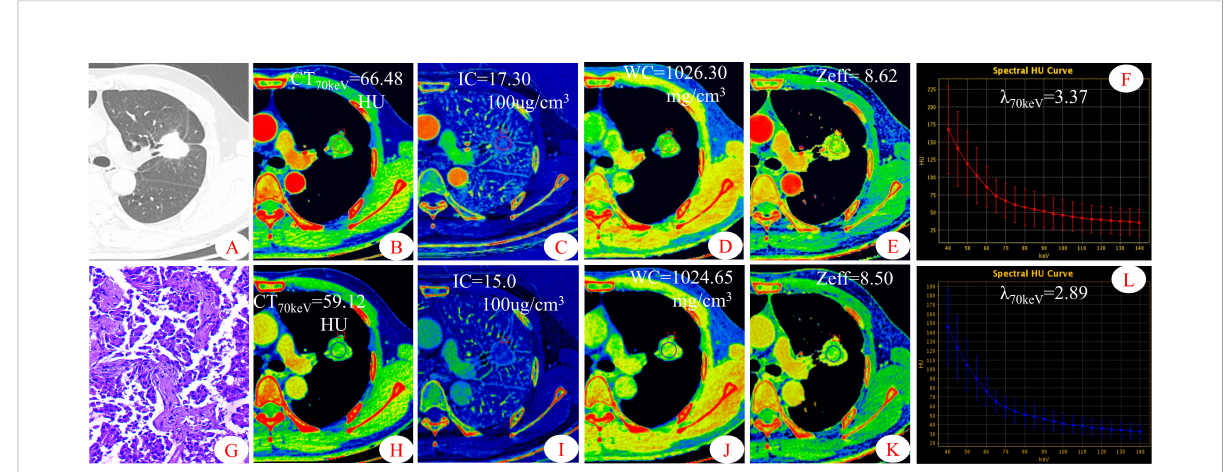
FIGURE 2 Dual-energy spectral CT images and pathological sections of a 45-year-old man with solitary lung adenocarcinoma (S-LUAD). (A) lung window; (B, H) 70keV single-energy pseudo-color images; (C, I) iodine concentration (IC) pseudo-color images; (D, J) water concentration (WC) pseudo-color images; (E, K) effective atomic number (Zeff) pseudo-color images; (F, L) spectral curves and slopes; (G) hematoxylin and eosin staining (original magni fi cation × 200). (B – F) arterial phase; (H – L) venous